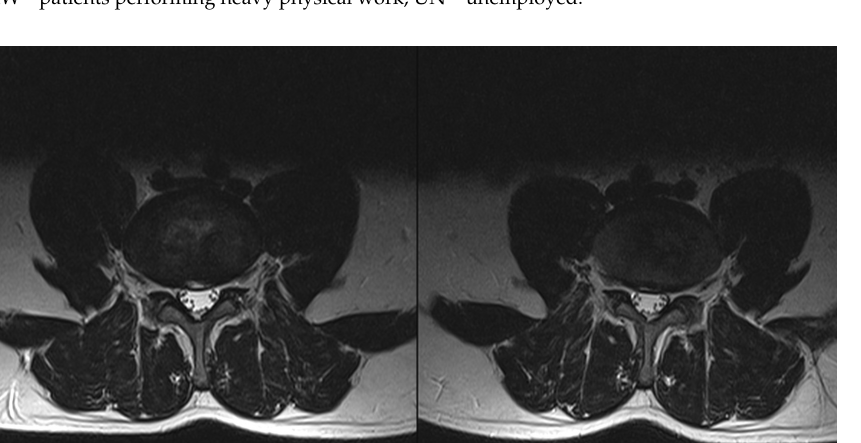
Figure 2. Pre- ( left ) and post-GEI ( right ) axial MRI at L4/L5 level of a patient with discogenic pain. MRI was performed two weeks before and six weeks after the